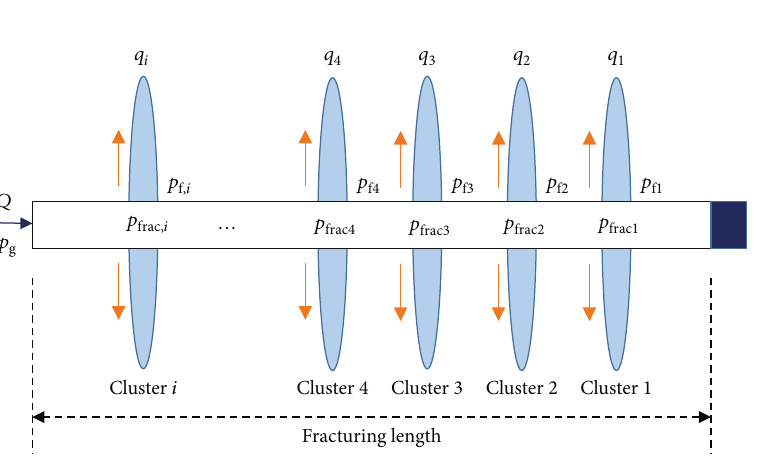
Figure 2: Schematic of multifracture